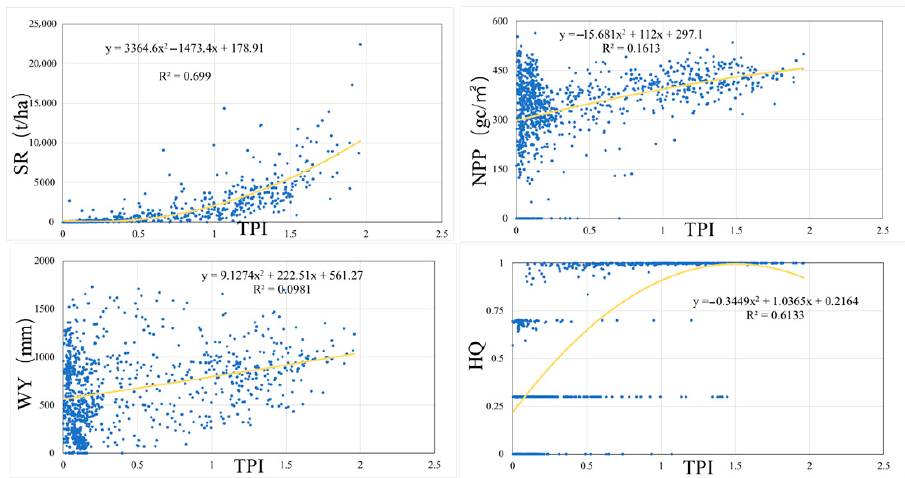
Figure 6. Analysis of vertical gradient characteristics of ecosystem services of urban agglomeration in the Yangtze River Delta.